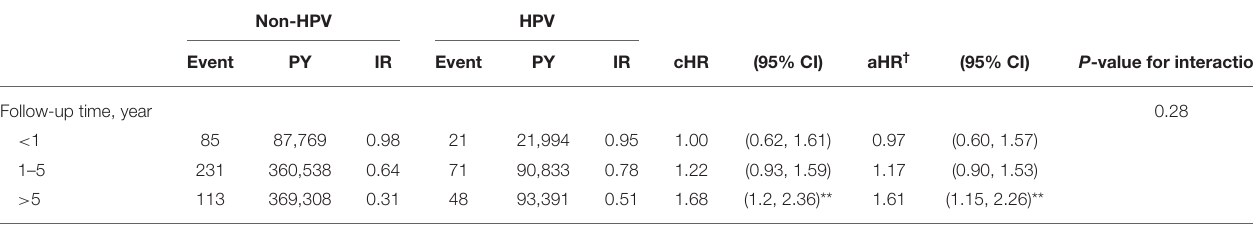
TABLE 4 | Bell’s palsy in different follow-up